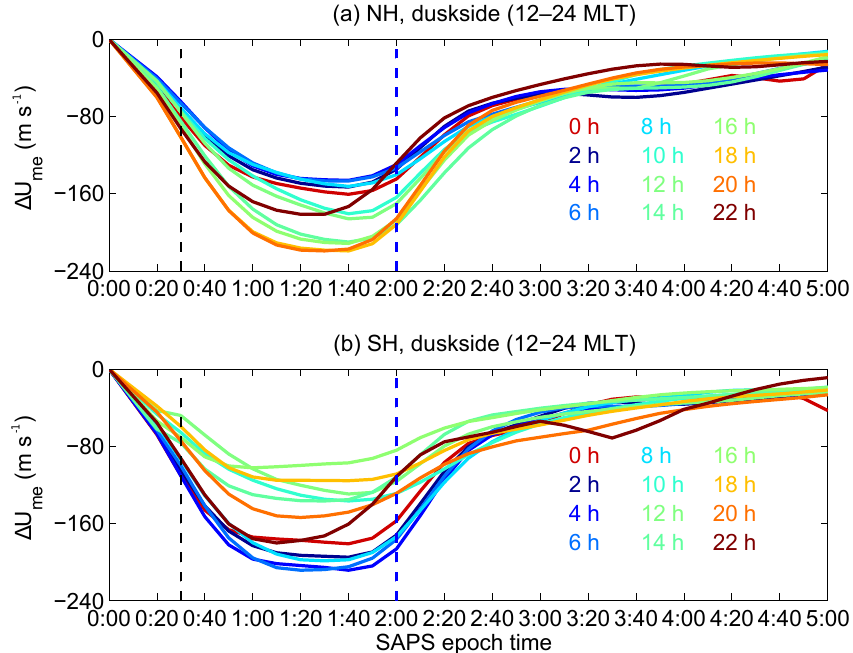
Figure 4. Time variation of the strongest disturbance neutral wind in the dusk sector (18:00–24:00MLT). Different colors represent SAPS onset times at 2h intervals from 00:00 to 22:00UT. The SAPS potential attains extreme values around 00:30epoch time, as indicated by the black vertical dashed line. SAPS become zero around 02:00epoch time, as indicated by the blue vertical line. The top panel is for the Northern Hemisphere, and the bottom panel is the Southern